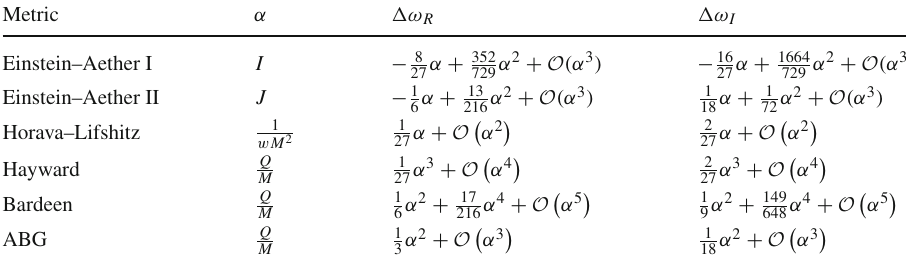
Table 2 Corrections for eikonal quasinormal modes in terms of the small parameters of the metrics